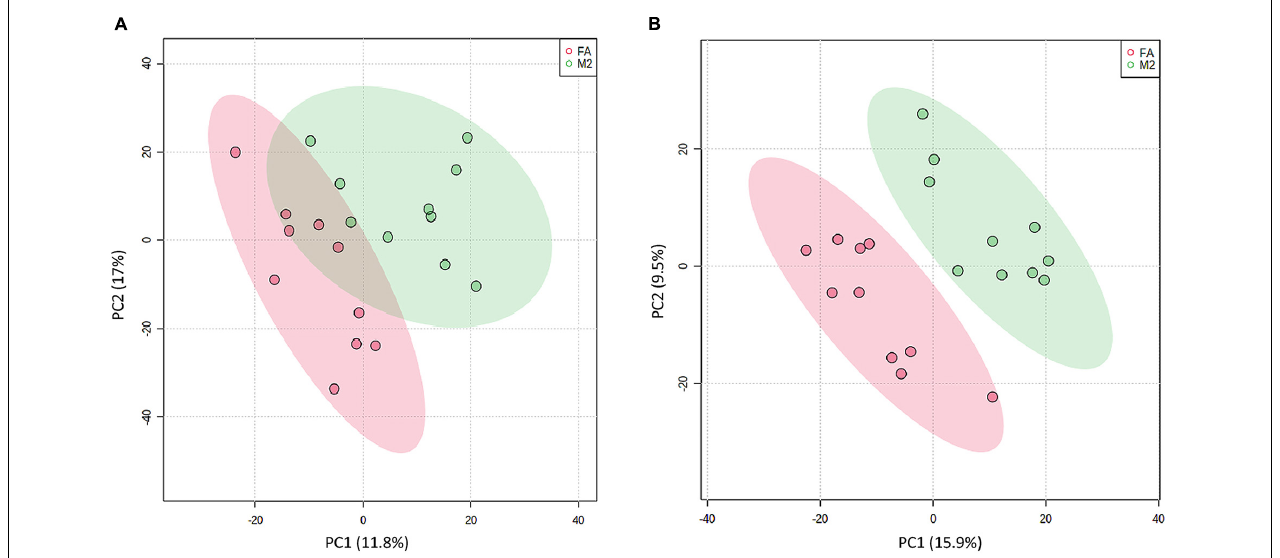
FIGURE 3 | Partial least-square discriminant analysis plot based on fecal metabolites. PLS-DA plot of fecal metabolites detected in positive (A) and negative modes (B) between FA and M2 groups. FA, pigs had free access to feed; M2, pigs were given two meals per day (0800 and 1800 h); each meal lasted 60